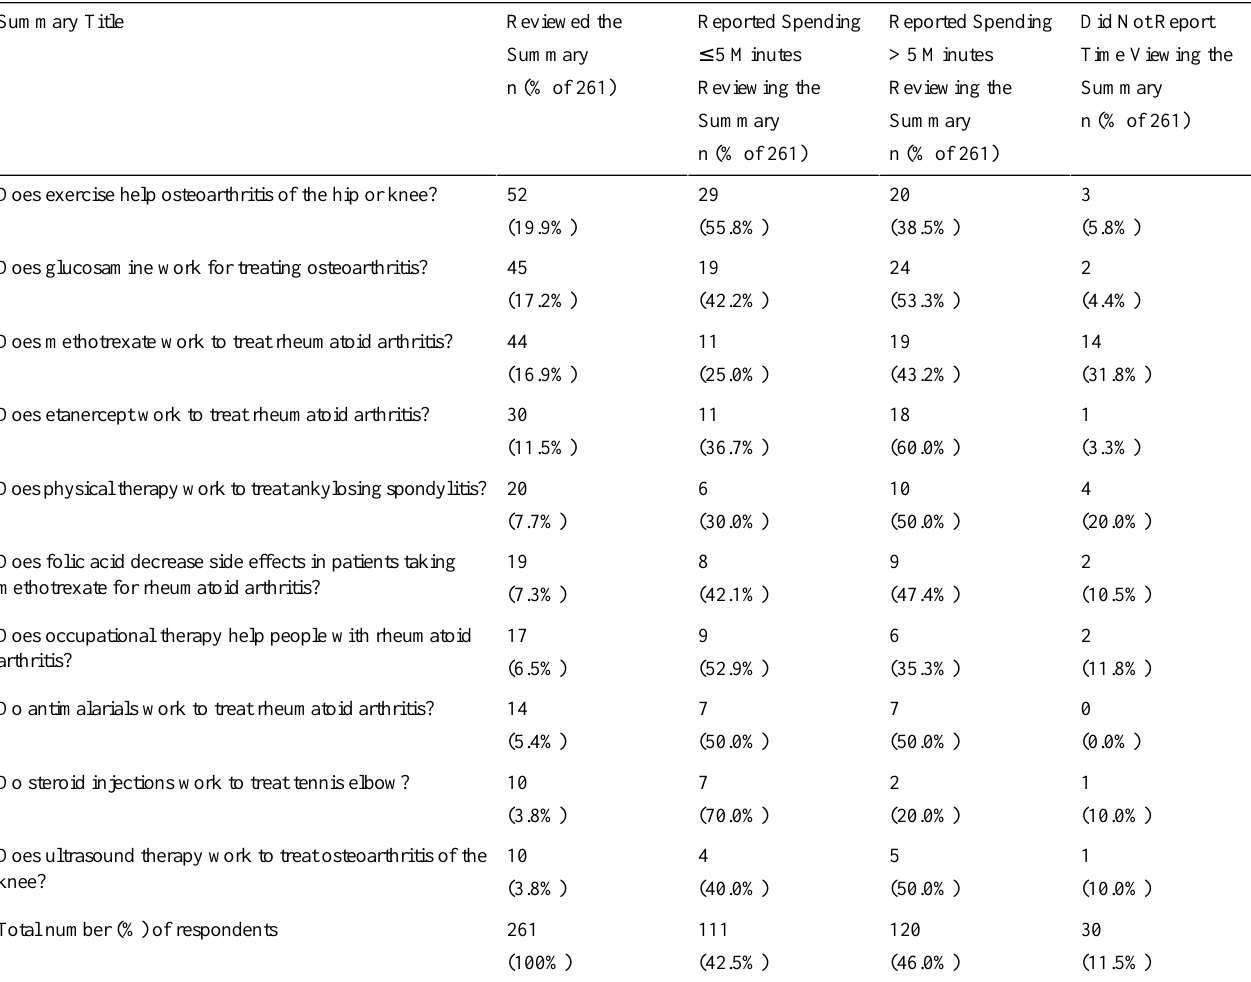
Table 3. Number and percentage of respondents reviewing each consumer summary and self-reported time spent reviewing that summary